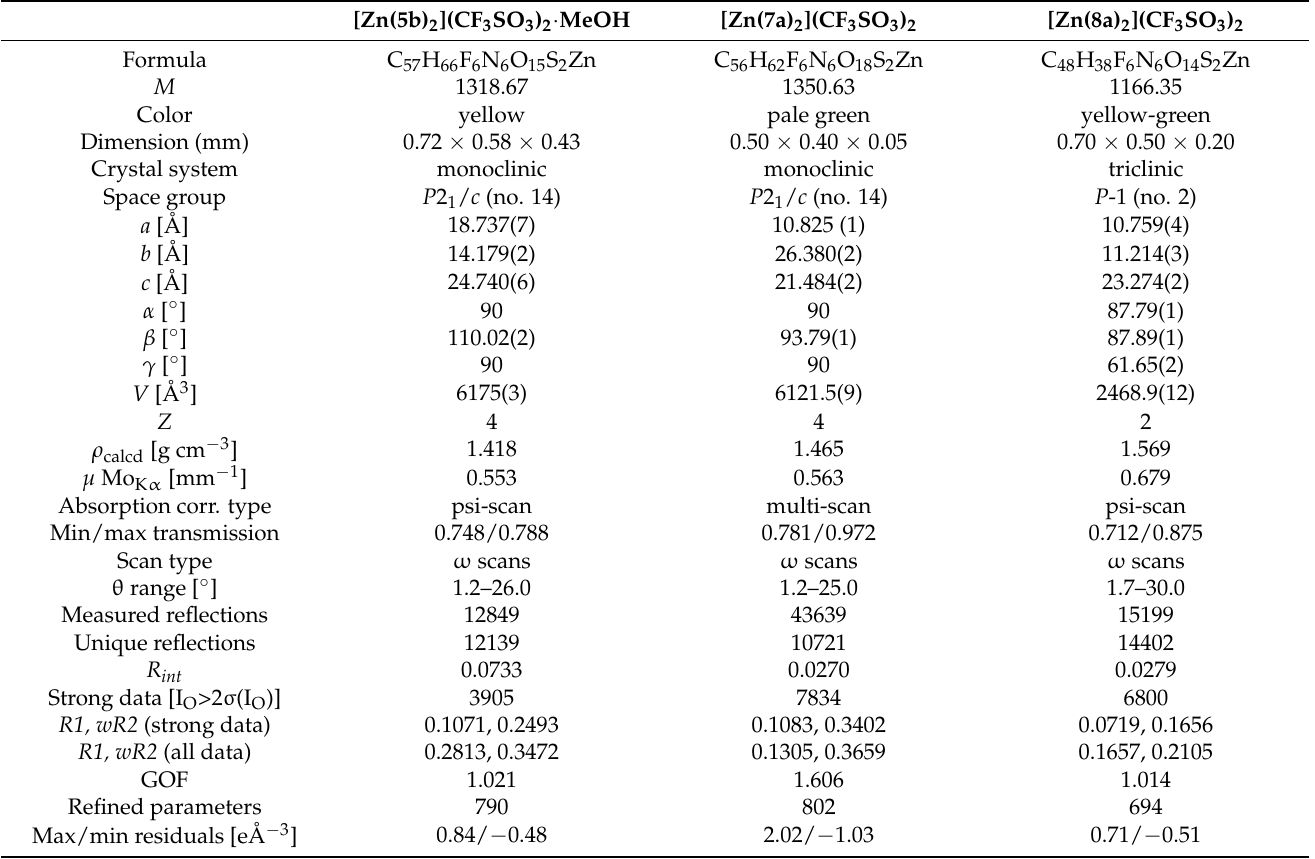
Table 1. Crystal data for investigated